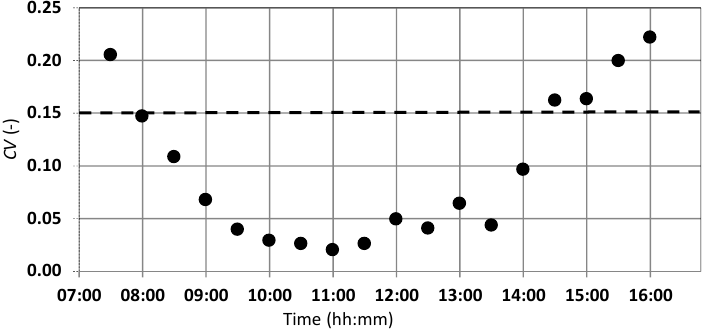
Figure 9. Half hourly temporal variability of the coefficient of variation, CV (unitless), evaluated over the time from 29 June to 2 August. The over-imposed dash line indicates a 15% limit of acceptability.